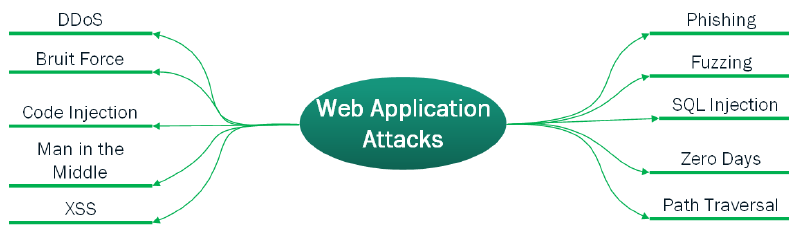
Figure 2. Different types of web attacks.